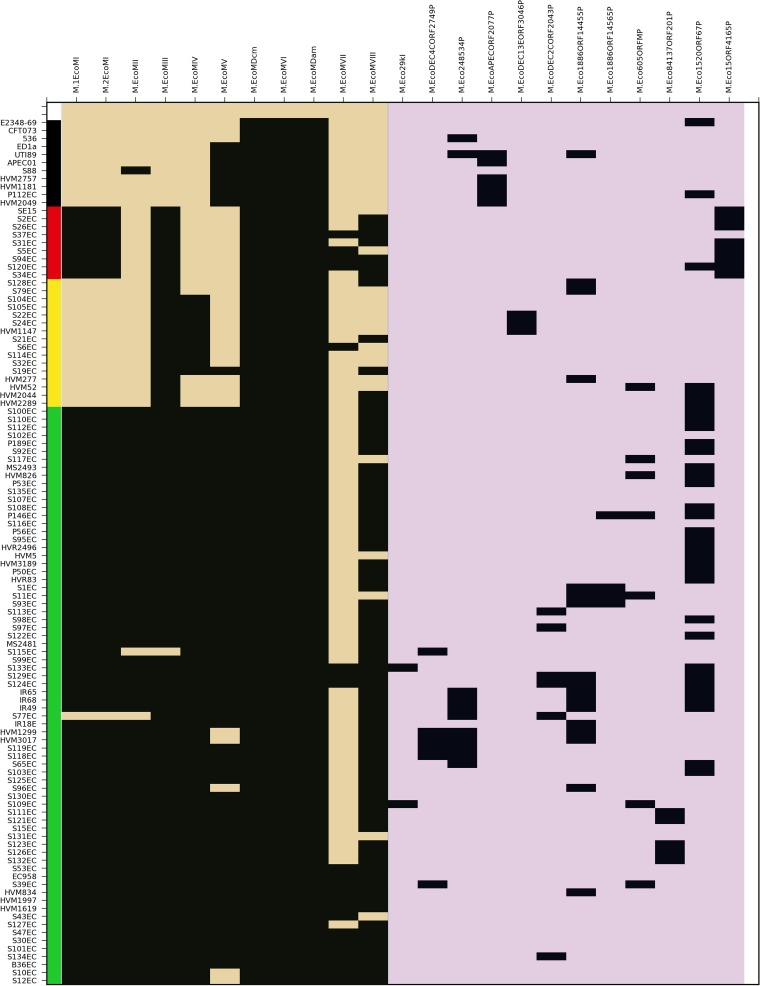
Distribution of MTases in ST131. MTases conserved in EC958 (tan) and those not encoded in EC958 (purple) are shown along the x axis with strain identifiers listed on the y axis in order of phylogenetic relatedness (6). Gene presence (black shading) is indicated by BLASTn comparison (≥95% nucleotide identity) of EC958 MTases and MTases from the REBASE database (15) to the draft assemblies of 95 ST131 strains and/or mapped reads for each ST131 strain (http://github.com/BeatsonLab-MicrobialGenomics/ST131_99/), as implemented in Seqfindr (http://github.com/mscook/seqfindr).